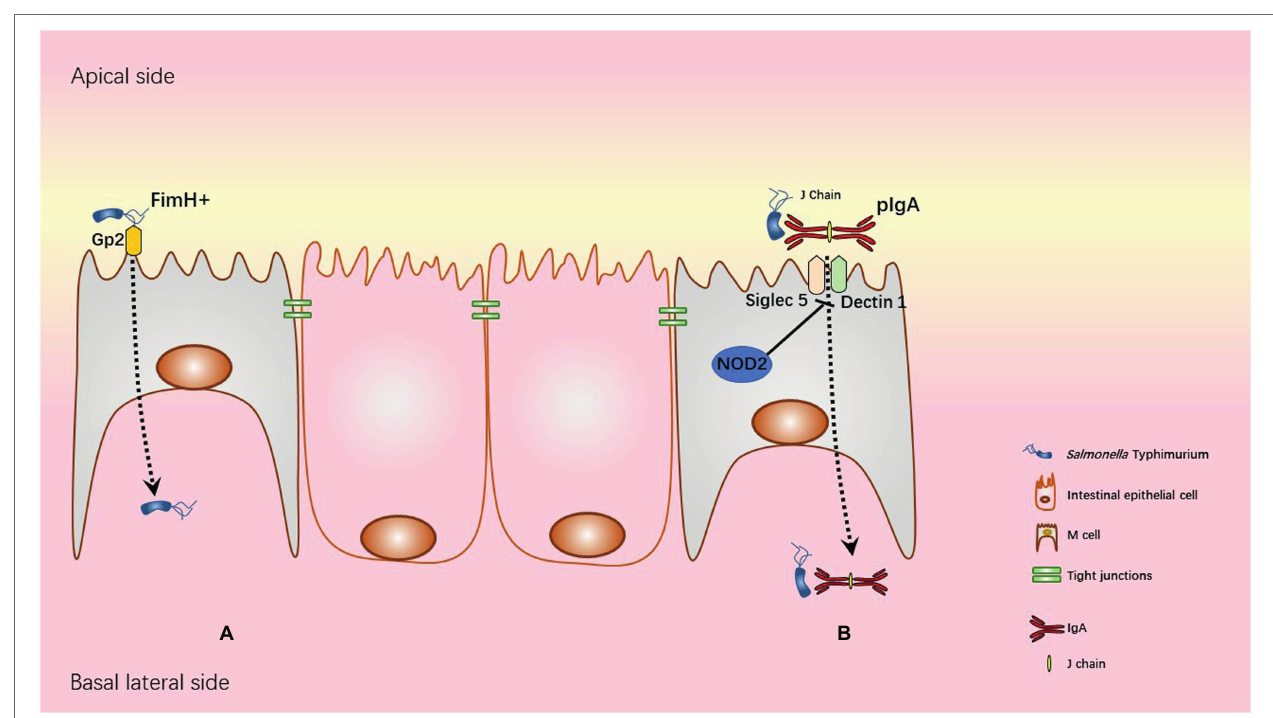
FIGURE 3 | Transcytosis mechanisms used by STm. (A) Glycoprotein 2 (GP2), specifically expressed on the apical membrane of M cells recognizes FimH, a component of type I pili on the STm outer membrane. This interaction allows STm transcytosis. (B) In physiological condition NOD2 WT is associated with inhibition of both Siglec5 and Dectin1 as represented in the figure. NOD2 polymorphisms R702W, FS1007insC, or R702W/G908R in human Crohn’s disease patients and Nod2 deficiency in mice are associated with overexpression of both Siglec5 and Dectin1 in M cells. Upregulation of Siglec5 and Dectin1 allows retrograde transport of pIgA (polymeric IgA)/STm immune complexes from the apical to basolateral side of M